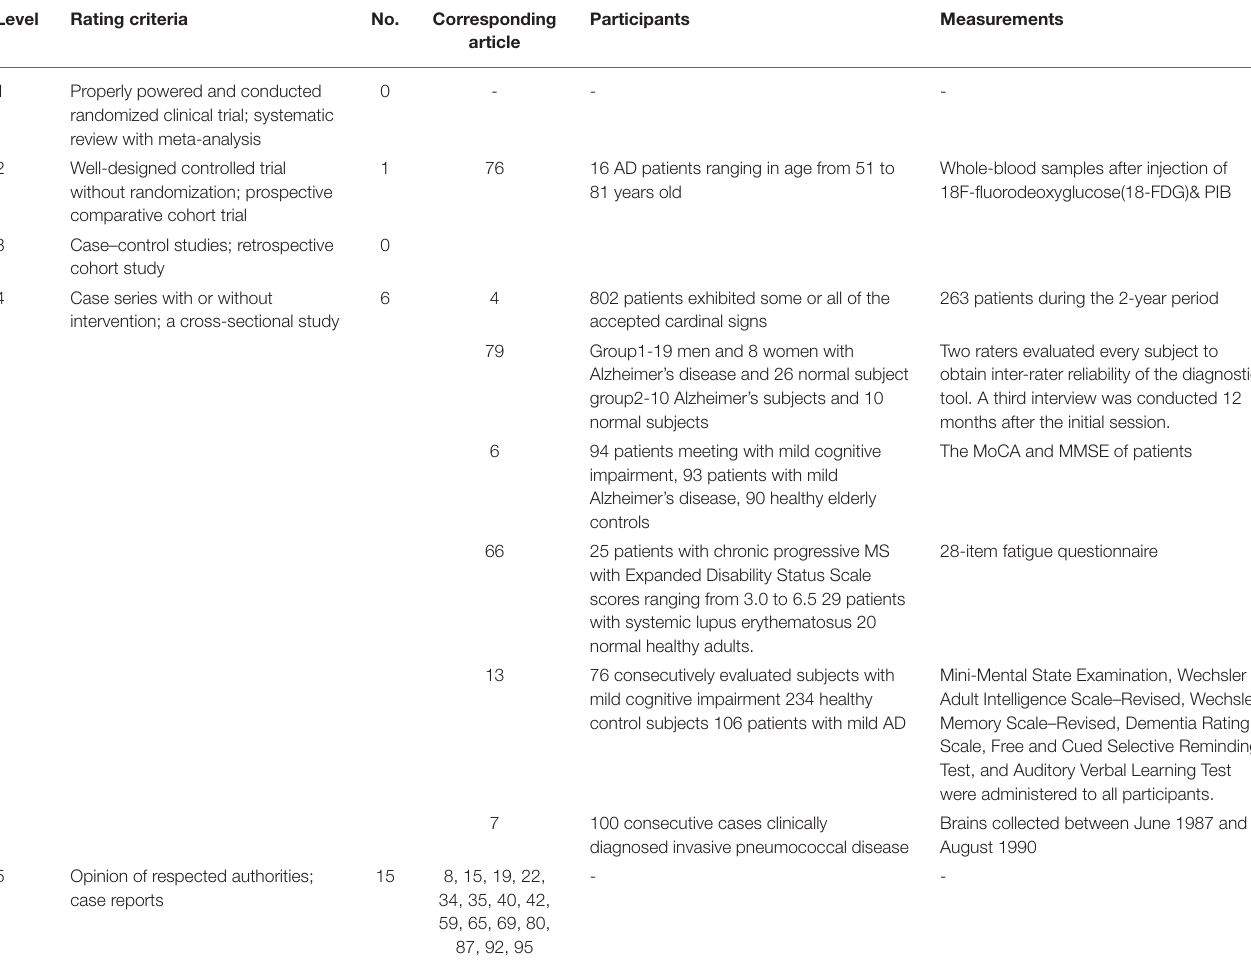
TABLE 3 | Evidence levels of clinical articles in 100 top-cited articles in neurodegenerative